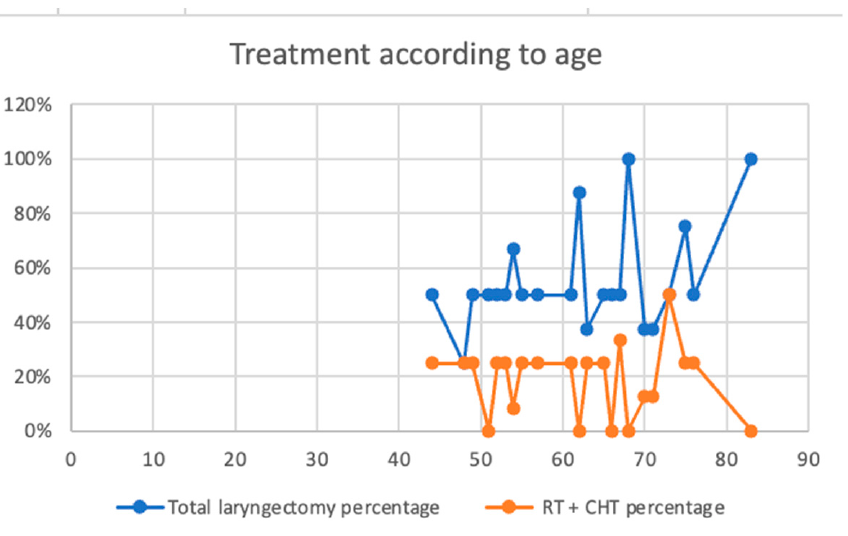
Figure 8. Treatment according to age.